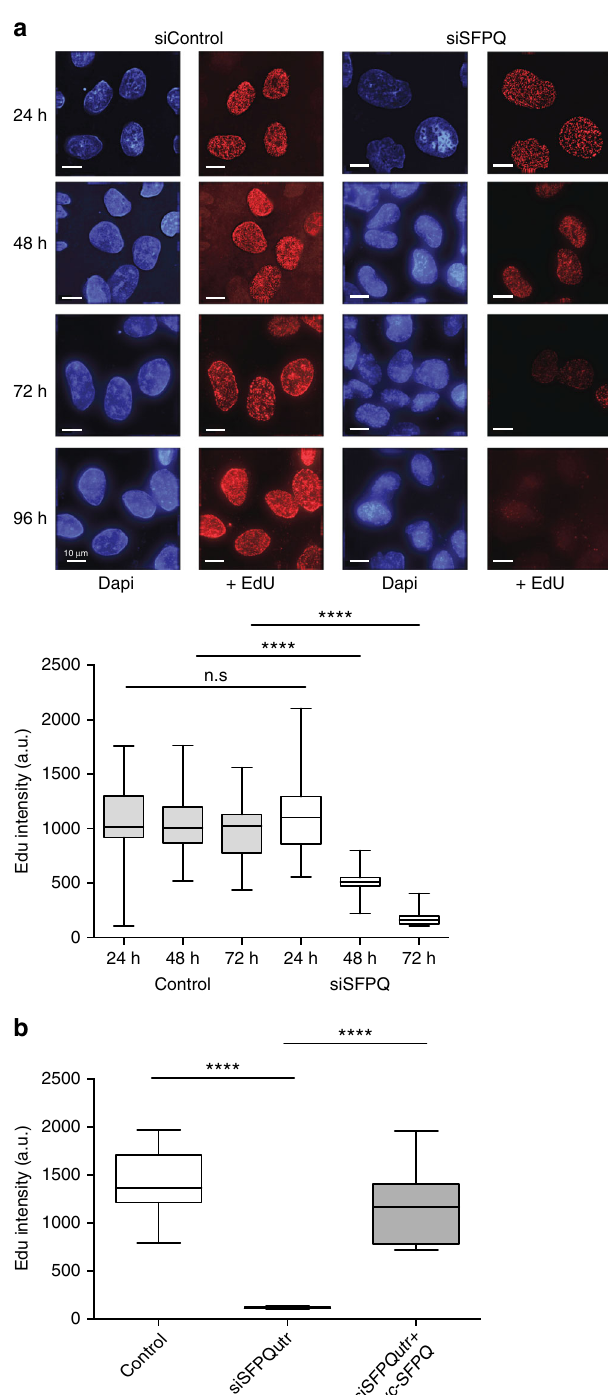
Fig. 3 Defects in SFPQ cause impaired DNA synthesis. a Microscope images showing that, in U2OS cells, incorporation of EdU into DNA over time is diminished by knockdown of SFPQ (siSFPQ8). Immuno fl uorescence intensity of nuclear EdU was quanti fi ed from >100 cells and is presented graphically as a box and whiskers plot. Statistical signi fi cance was determined using Mann – Whitney test (**** p <0.0001). Scale bars represent 10 μ m. b Expression of siRNA-resistant myc-SFPQ in U2OS cells restores